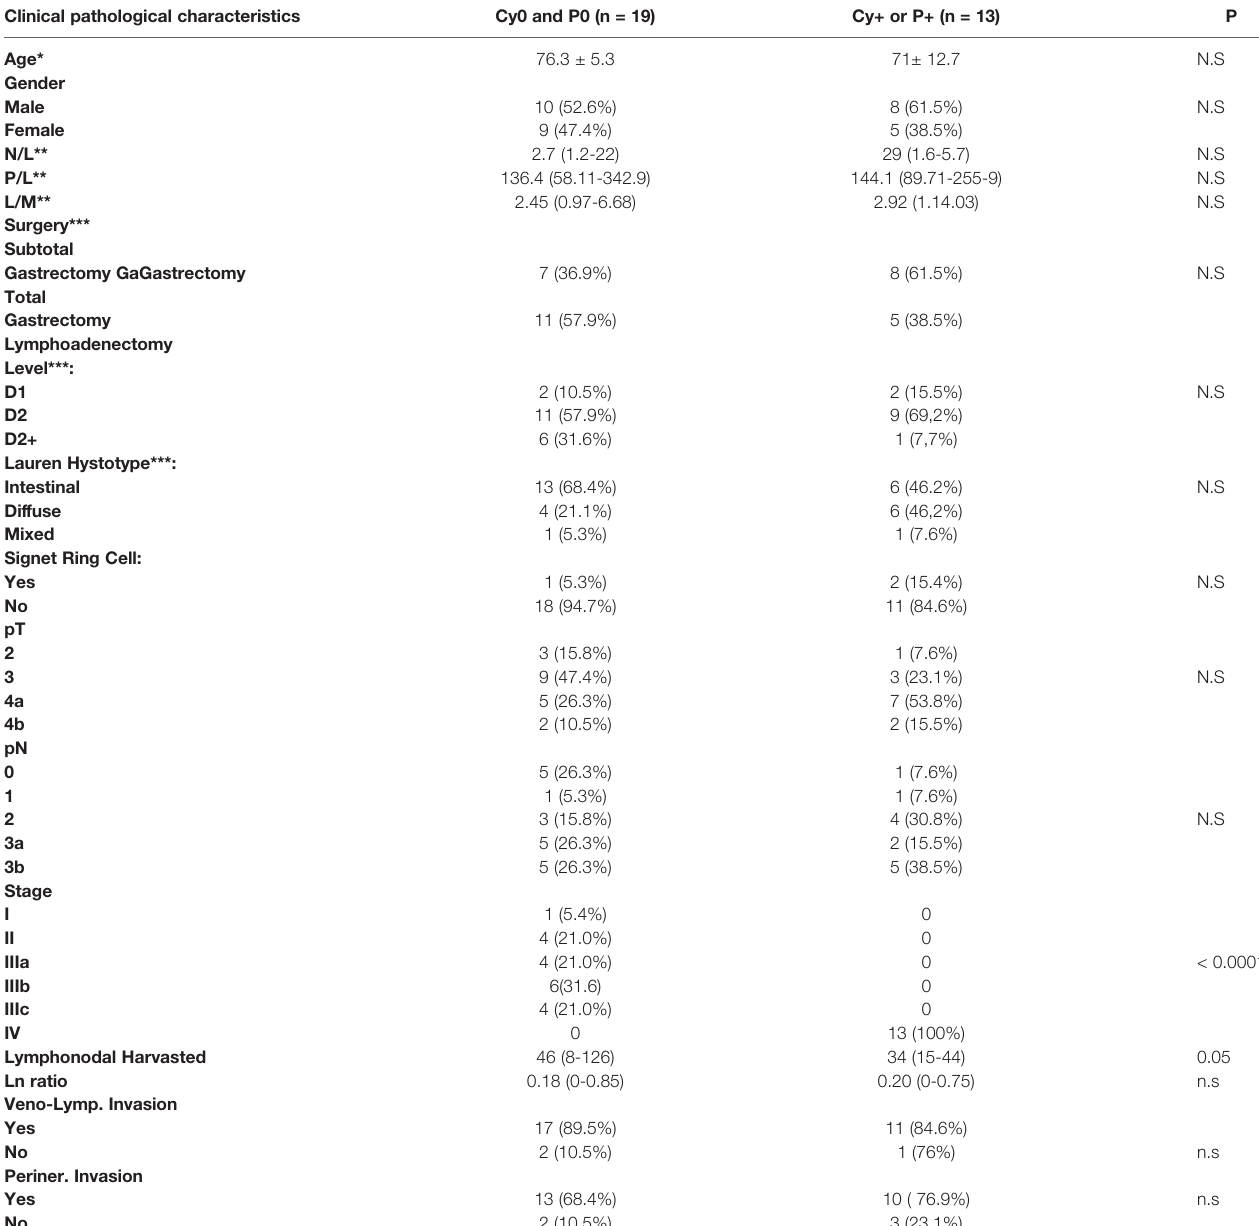
TABLE 1 | Clinical and pathological characterization of patients population at baseline. Clinical pathological